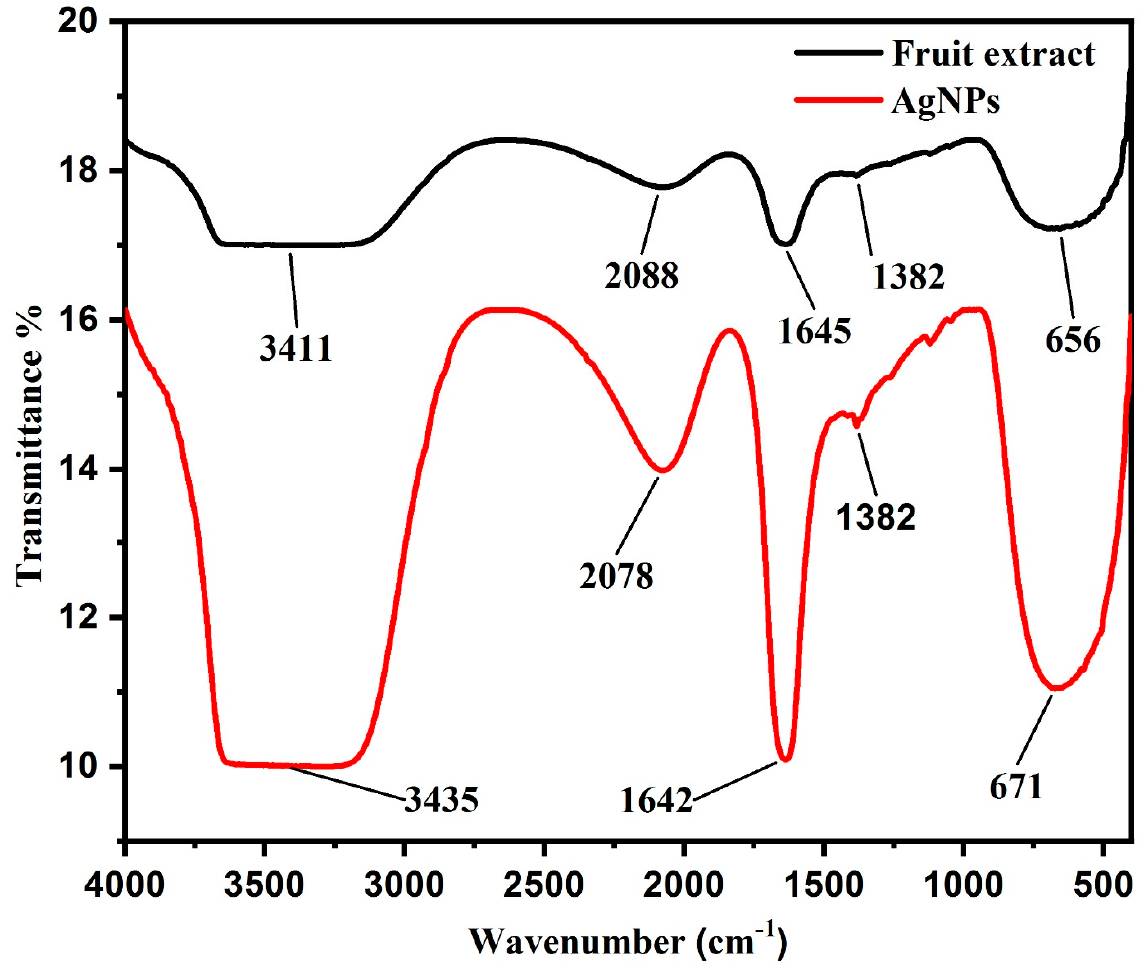
Figure 7. FTIR spectral analysis of Diospyros malabarica aqueous fruit extract and synthesized AgNPs.